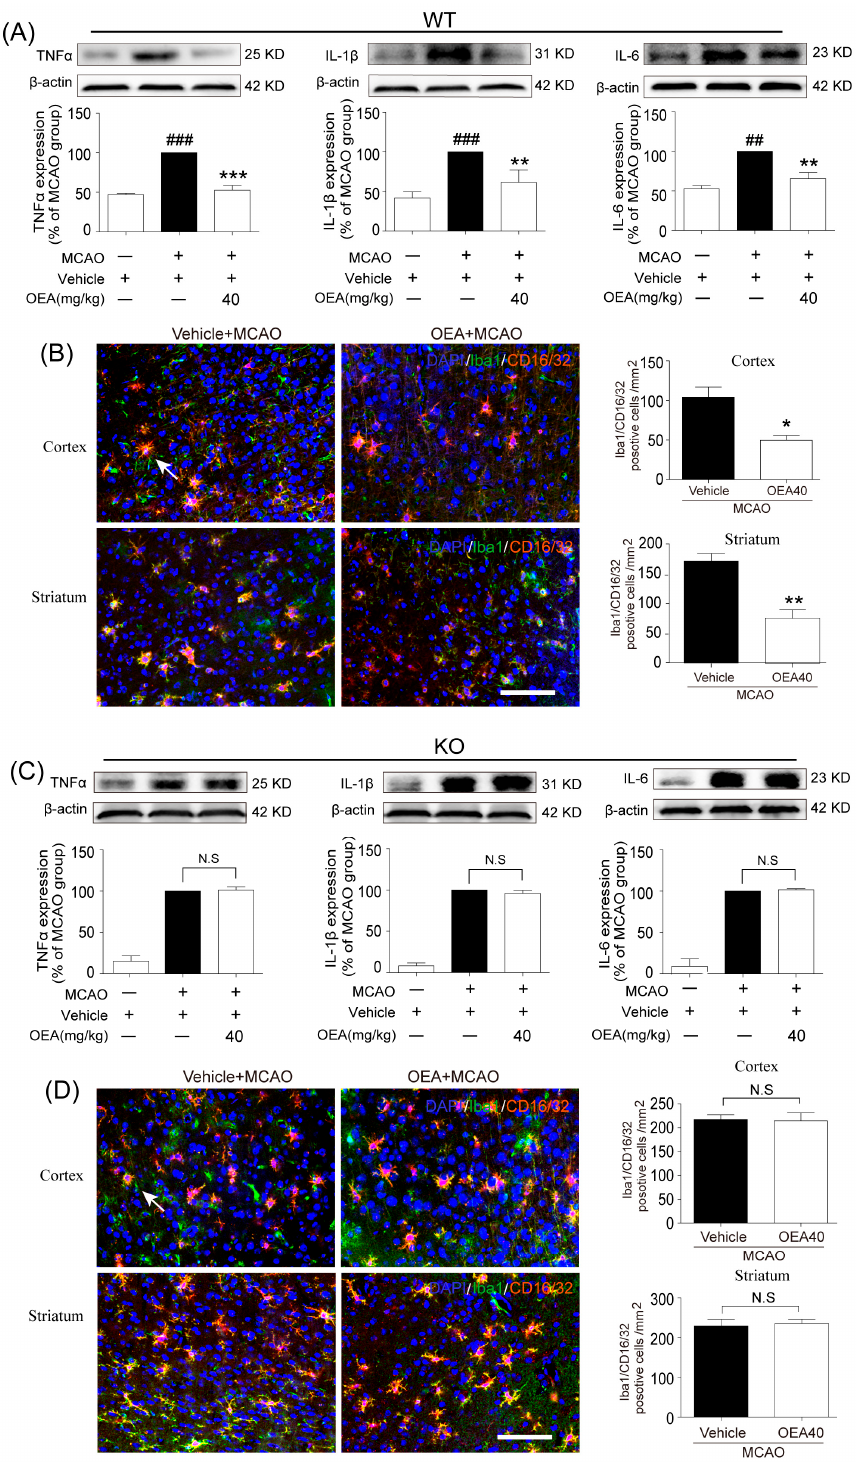
Figure 1. Oleoylethanolamide (OEA) treatment suppresses microglia M1 polarization in the injured cortex and striatum in wild-type (WT) but not PPAR α -knock-out (KO) mice at 3 days after middle